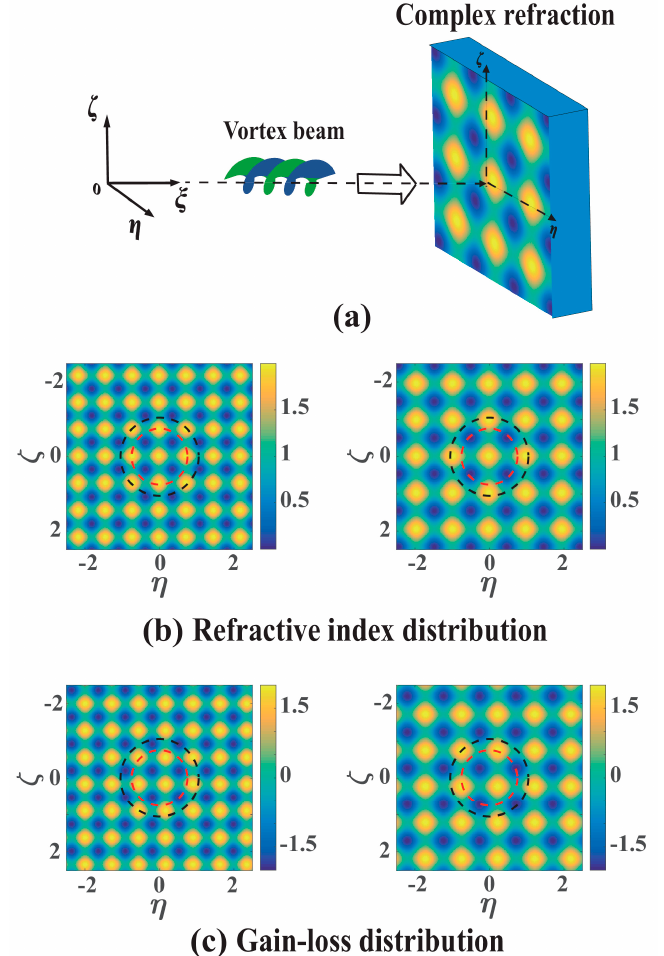
Figure 1. Diagrammatic sketch of vortex beams in a Kerr-SCPT medium: ( a ) the interaction between vortex beams and the Kerr-SCPT medium; ( b ) refractive index distribution, the left plot d = 0.23, the right plot d = 0.31; ( c ) gain-loss distribution, the left plot d = 0.23, the right plot d = 0.31. The black and the red dashed ring lines overlapped in ( c ) represent the initial beam width when the vortex topological charge was n = 1 and n = 2, respectively.